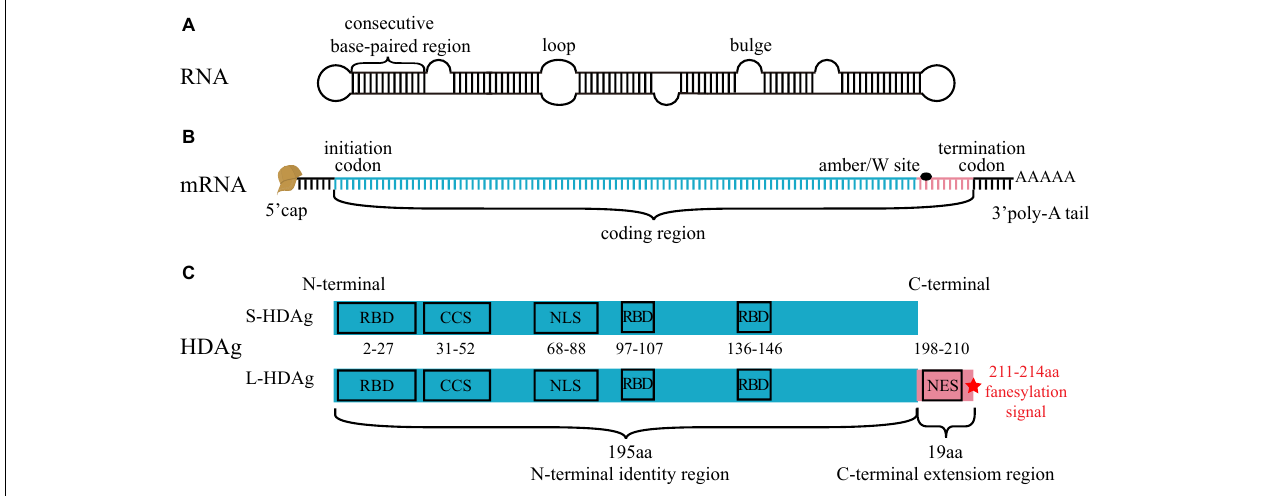
FIGURE 1 | Structure of HDV RNA, mRNA and HDAg. (A) HDV RNA is a circular single-stranded RNA, 74% ribonucleotides form consecutive base-paired regions, interspersed by small loops or bulges formed by the unpaired ribonucleotides. All ribonucleotides fold into a quasi-double-stranded, unbranched rod-like structure. (B) There are a 5 (cid:48) cap, a 3 (cid:48) poly-A tail, and a coding region in HDV mRNA. The ribonucleotides from initiation codon to amber/W site (blue segment) encodes S-HDAg and L-HDAg N-terminal identity region, and the ribonucleotides from amber/W site to termination codon (pink segment) encodes L-HDAg C-terminal extension region. (C) S-HDAg and L-HDAg are characterized by three RNA-binding domains (RBD), a coiled-coil sequence (CCS), a nuclear localization signal (NLS) in the N-terminal identity region (blue box), and a nuclear export signal (NES), a farnesylation signal (red star) in the C-terminal extension region (pink box).